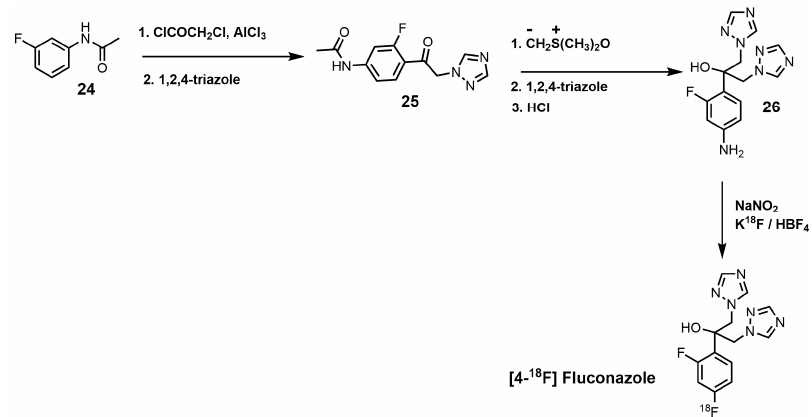
Figure 13. Synthesis of [4- 18 F]fluconazole.